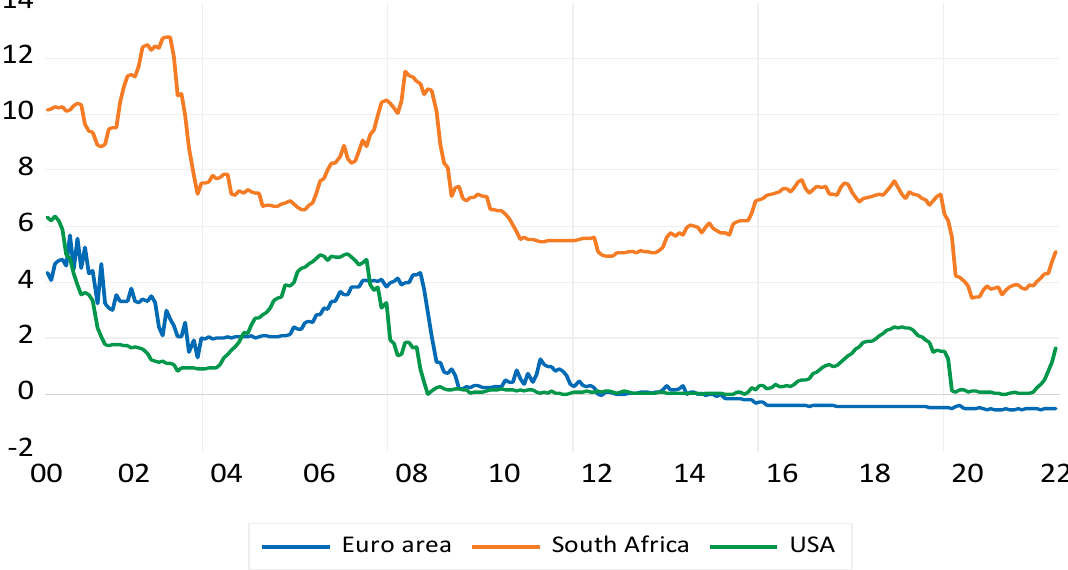
Figure 2. Short-term interest rates in the US, Euro area and South Africa.